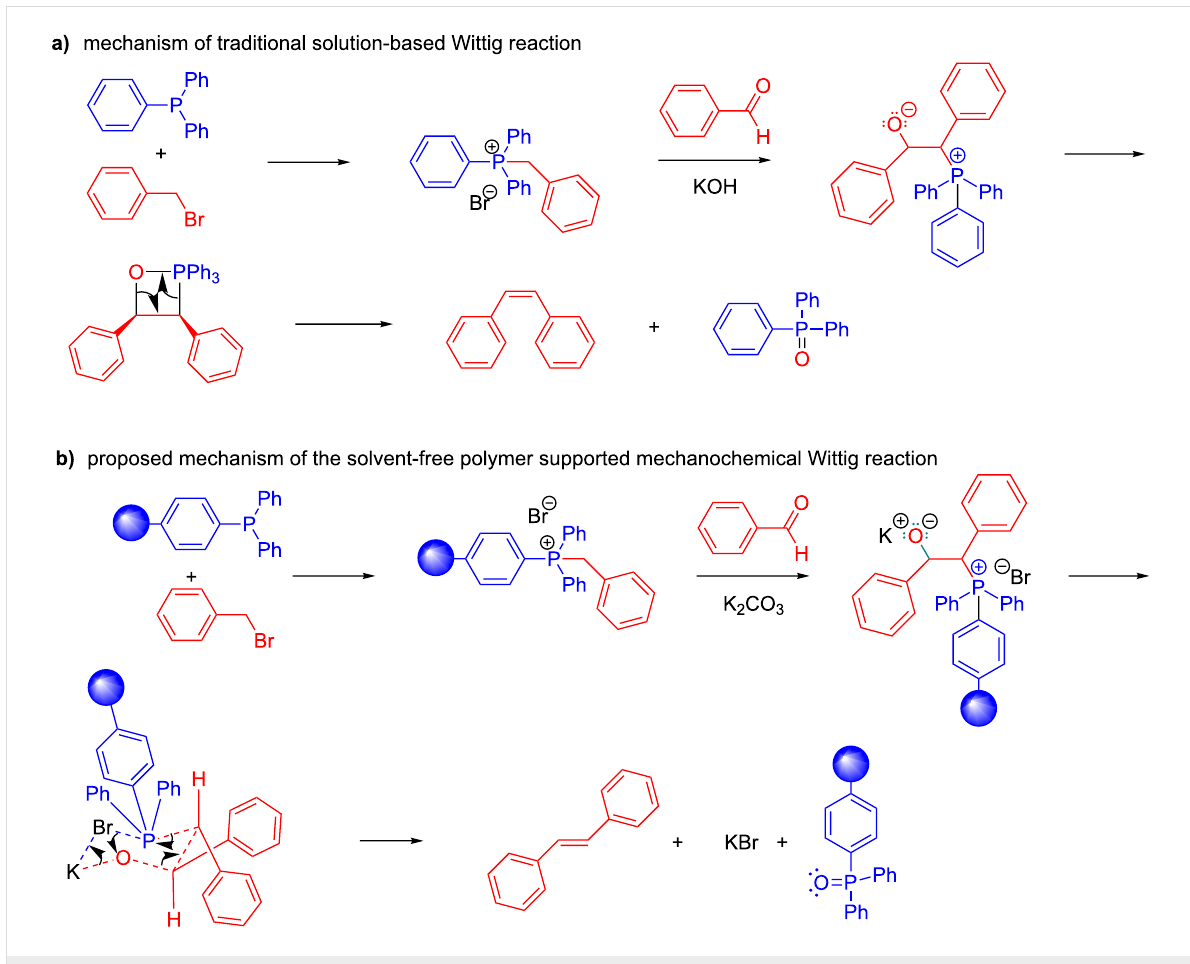
Figure 3: Comparison of solution based Wittig reaction (a) with polymer-supported mechanochemical Wittig reaction (b).